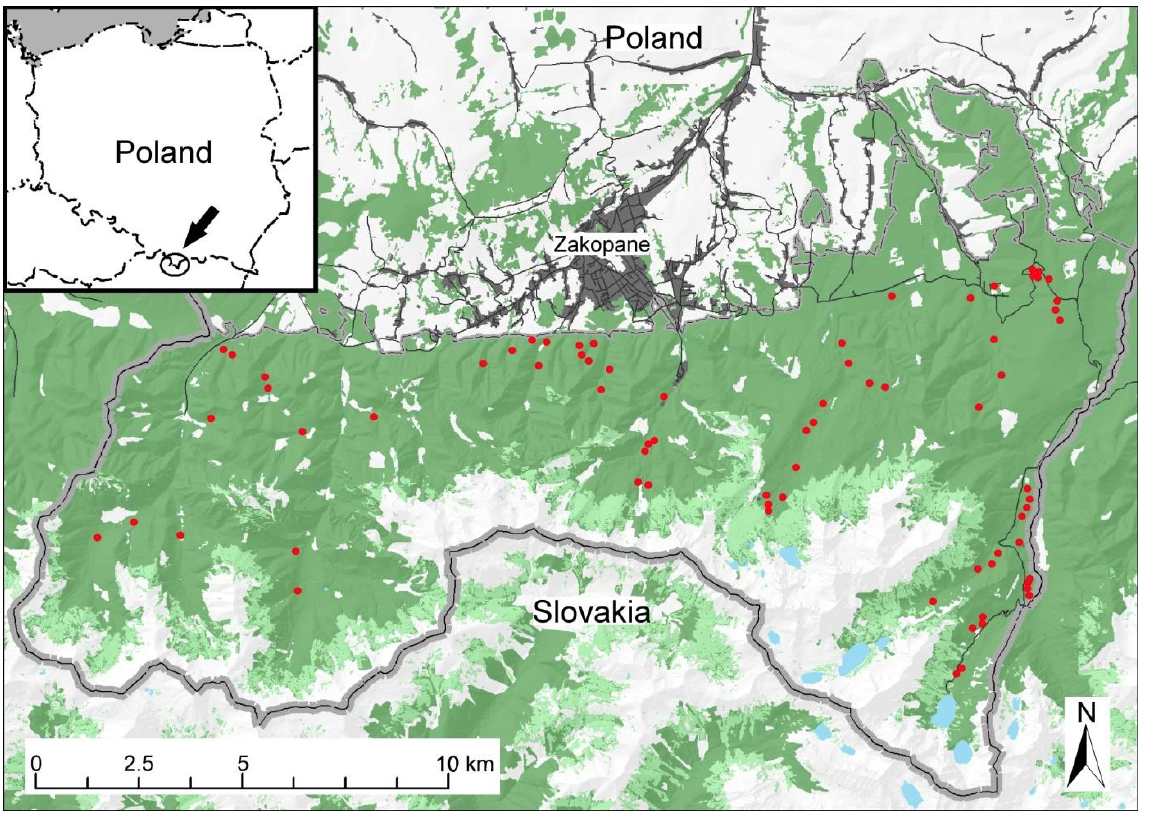
Figure 1. Location of the study area in Poland (top left) and location of 73 mist-netting sites (filled red circles) in the Polish Tatra Mountains (bottom) in the years 2016 – 2020.